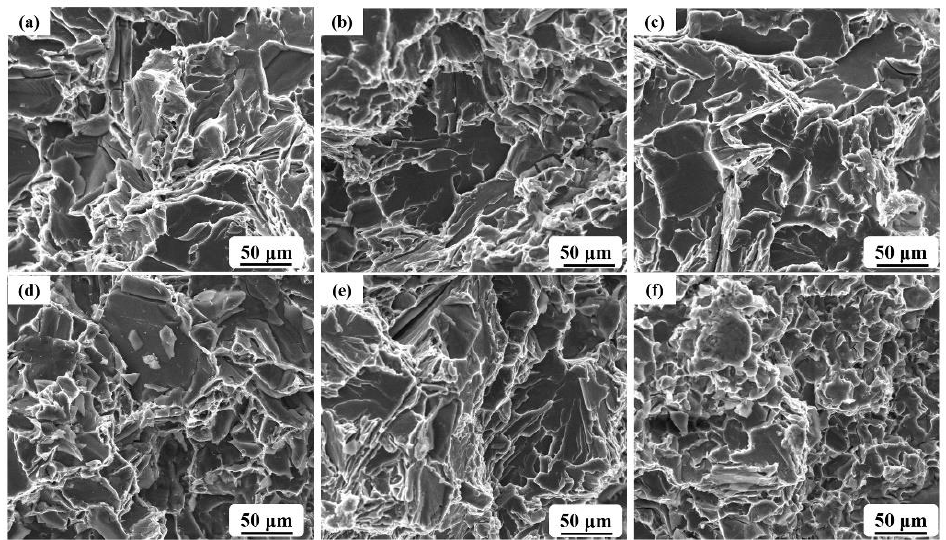
Figure 8. Fracture morphology of different phenolic resin addition samples: ( a ) blank sample; ( b , c ) 0.3% resin added; and ( d – f ) are 0.9 – 2.1% resin added samples.